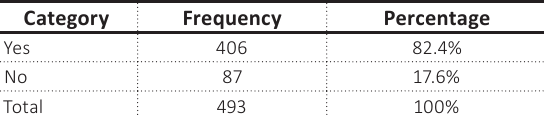
Table 2. Frequency distribution of the study